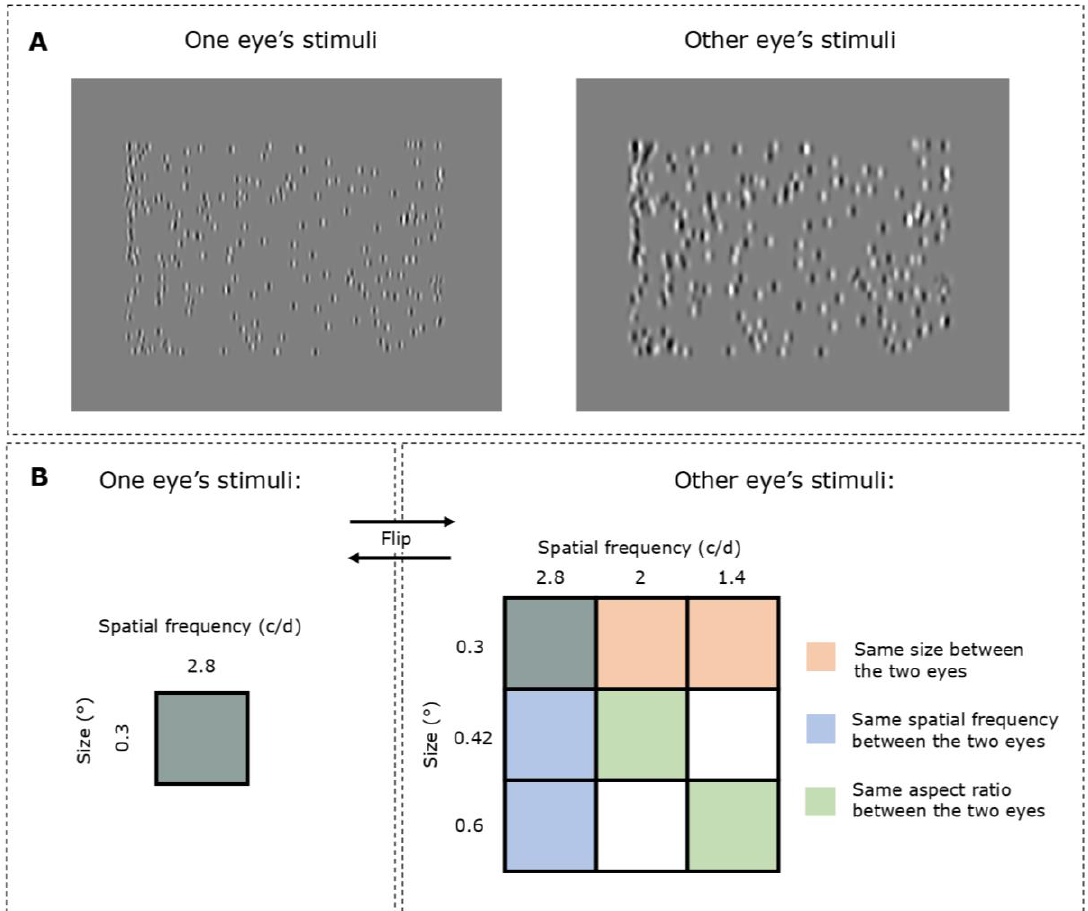
Figure 2. Stimuli and the experiment design. ( A ) The stimulus was presented dichoptically, with di ff ering or the same values of either spatial frequency and / or size of the Gabor elements in each eye. In this example, the left eye is shown Gabor elements at 0.3 ◦ size (sigma parameter of the Gabor) and 2.8 c / d spatial frequency, whereas the right eye is shown Gabor elements at 0.42 ◦ size and 2.0 c / d spatial frequency. ( B ) A diagrammatic explanation of the experiment design. Subjects were shown Gabor elements that had a spatial frequency of 2.8 c / d and size of 0.3 degrees to one eye and a combination of other spatial properties to the other eye. The conditions were then reversed so that the former eye would be shown Gabor elements from the combinations of spatial frequency and size.